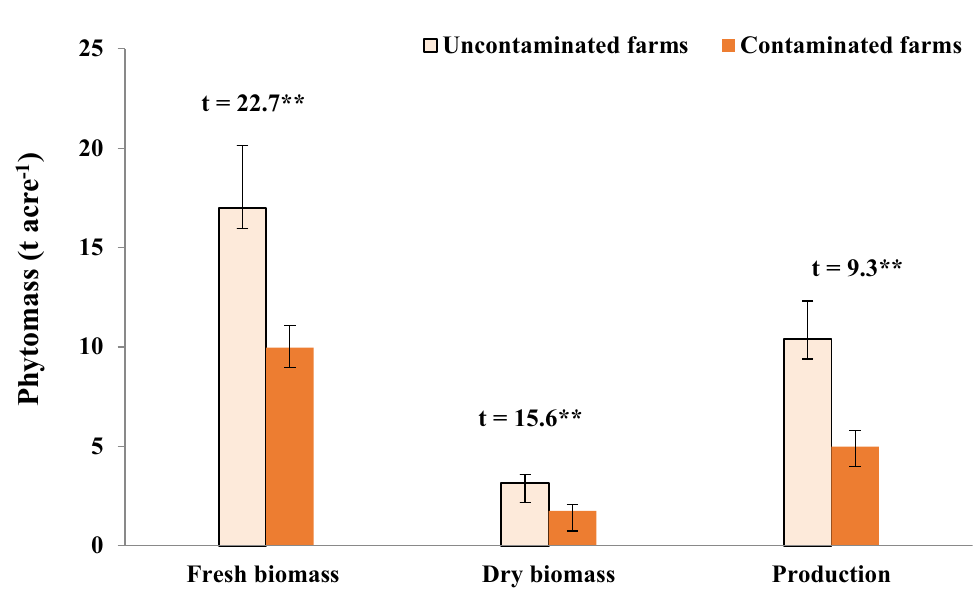
Figure 2. Biomass and production of eggplant crop grown in uncontaminated and contaminated farms. Vertical bars are standard deviation. **: p < 0.01.